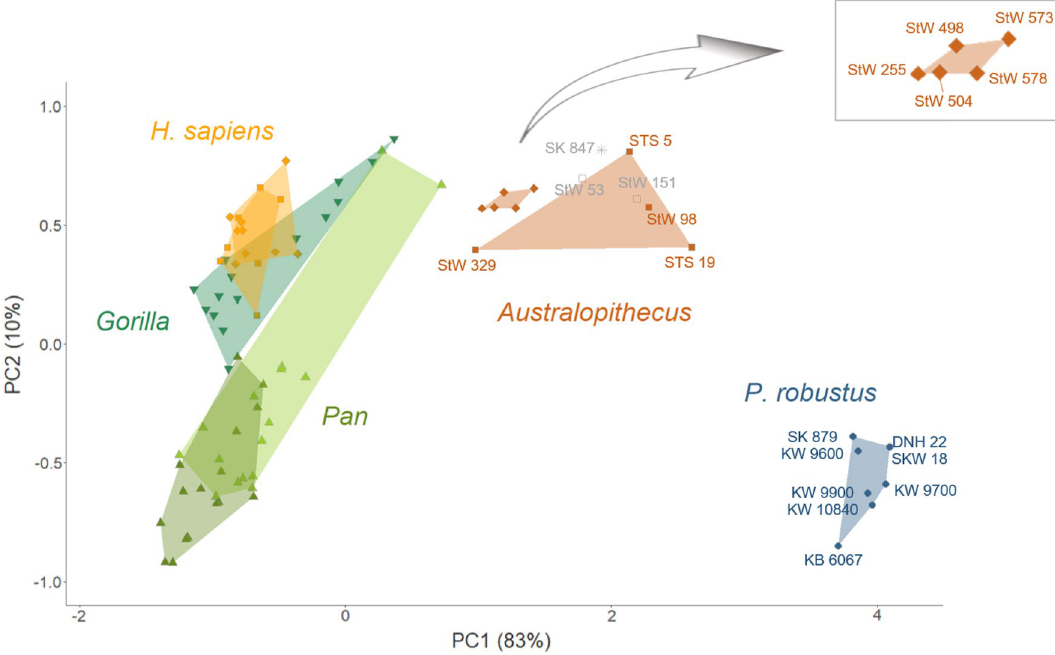
Figure 3. Tangent principal component analysis (TPCA) of cochlear curves compared using curvature and torsion. Blue circles are for P. robustus from Kromdraai (including the new specimens from Kromdraai, KW 9600, KW 9700, KW 9900, KW 10840), Swartkrans and Drimolen; brown diamonds and squares are for A. africanus from Sterkfontein, including five specimens that have been suggested sample a second species 19 (diamonds) also illustrated in the enlarged box (top right); light and dark green triangles are for pygmy and common chimpanzees, respectively; green inverted triangles are for gorillas; orange squares and diamonds are for male and female modern humans, respectively; star is for SK 847 (early Homo ); open grey squares are for StW 151 and StW 53 (here considered as “indeterminate”). Note that DNH 22 and SKW 18 overlap because their cochlear curves are nearly identical and their PC1 and PC2 values are